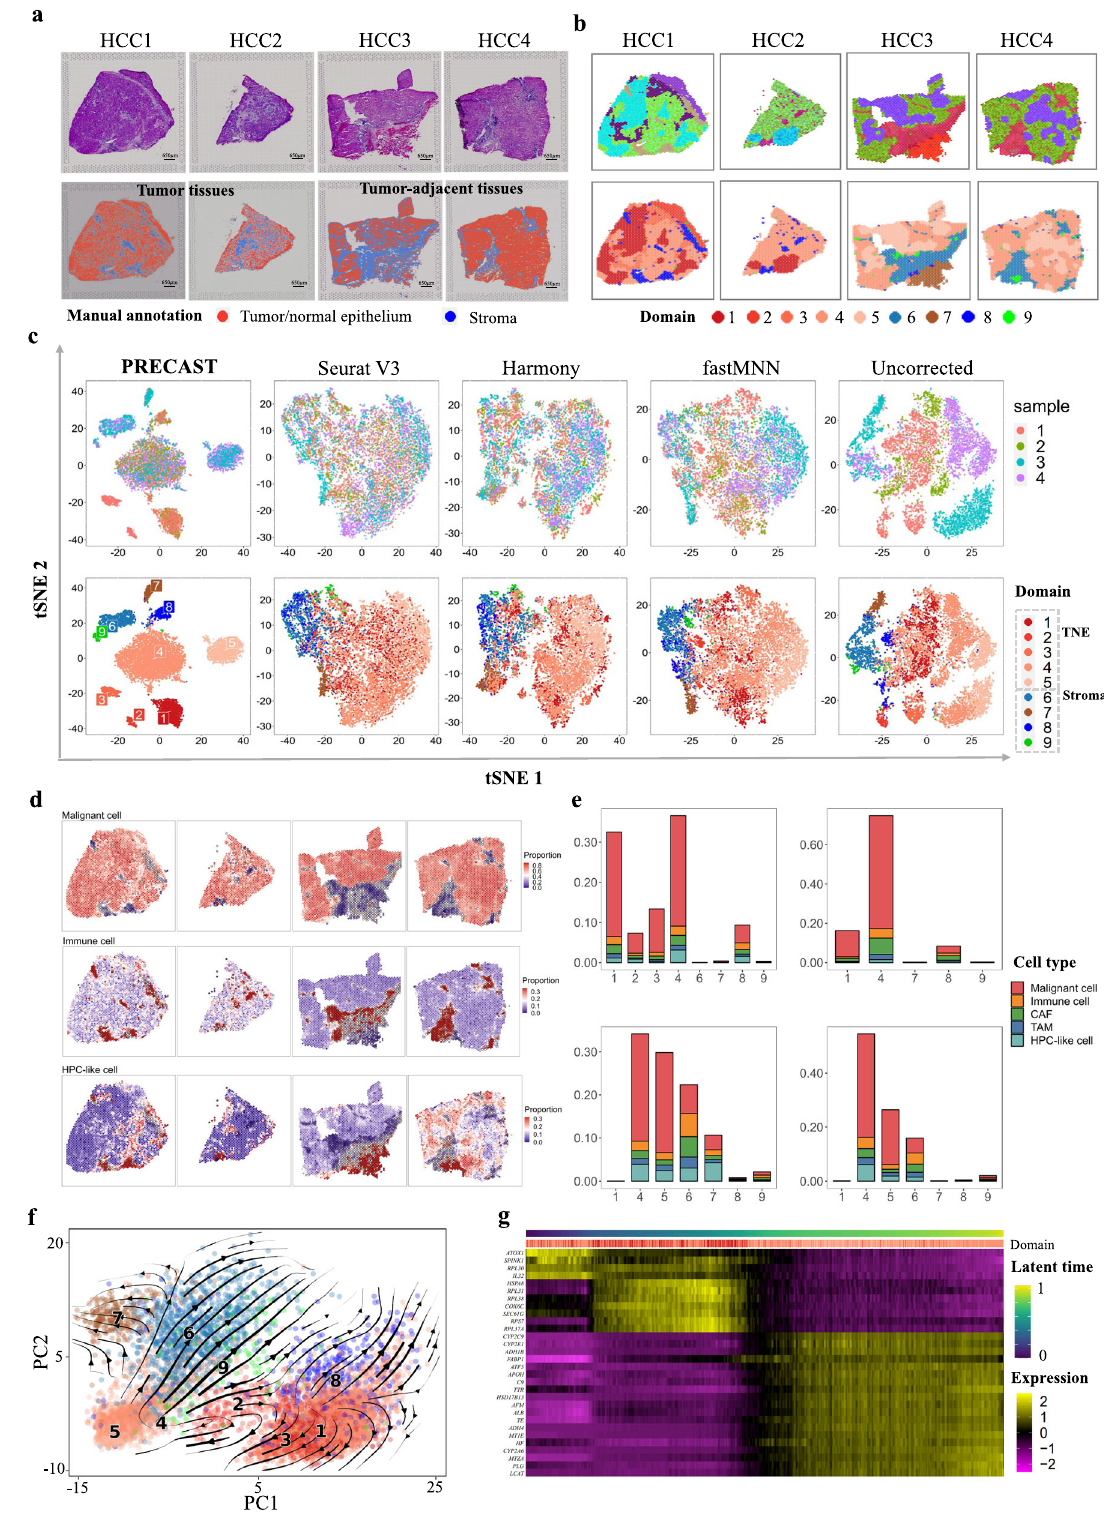
Fig. 5 | Analysis of data for four human HCC sections. a Top panel: H& E images from four tissue slides. Bottom panel: Manual annotation by a pathologist of four tissue slides. b Top panel: UMAP RGB plots of PRECAST for four tissue slides. Bottom panel: Clustering assignment heatmaps for four tissue sections by PRE- CAST.Color scheme for clustering assignment heatmapin PRECAST is the sameas in( c ),( f ),and( g ). c tSNEplotsforfourdataintegrationmethodswiththeright-most